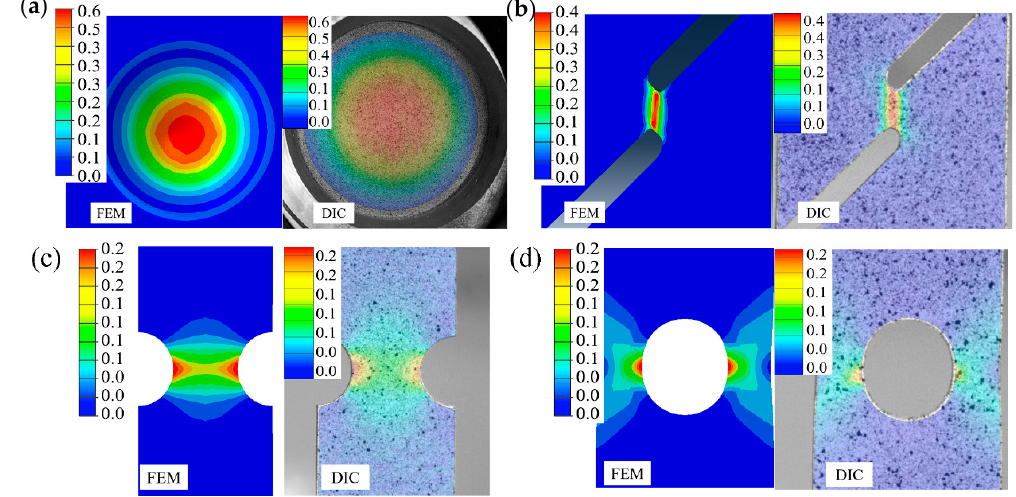
Figure 9. Comparison of strain distribution on a deformed surface in ARAMIS 2017 test ( right ) and FE model ( left ): ( a ) Nakajima specimen; ( b ) shear specimen; ( c ) notched specimen; ( d ) central hole specimen.